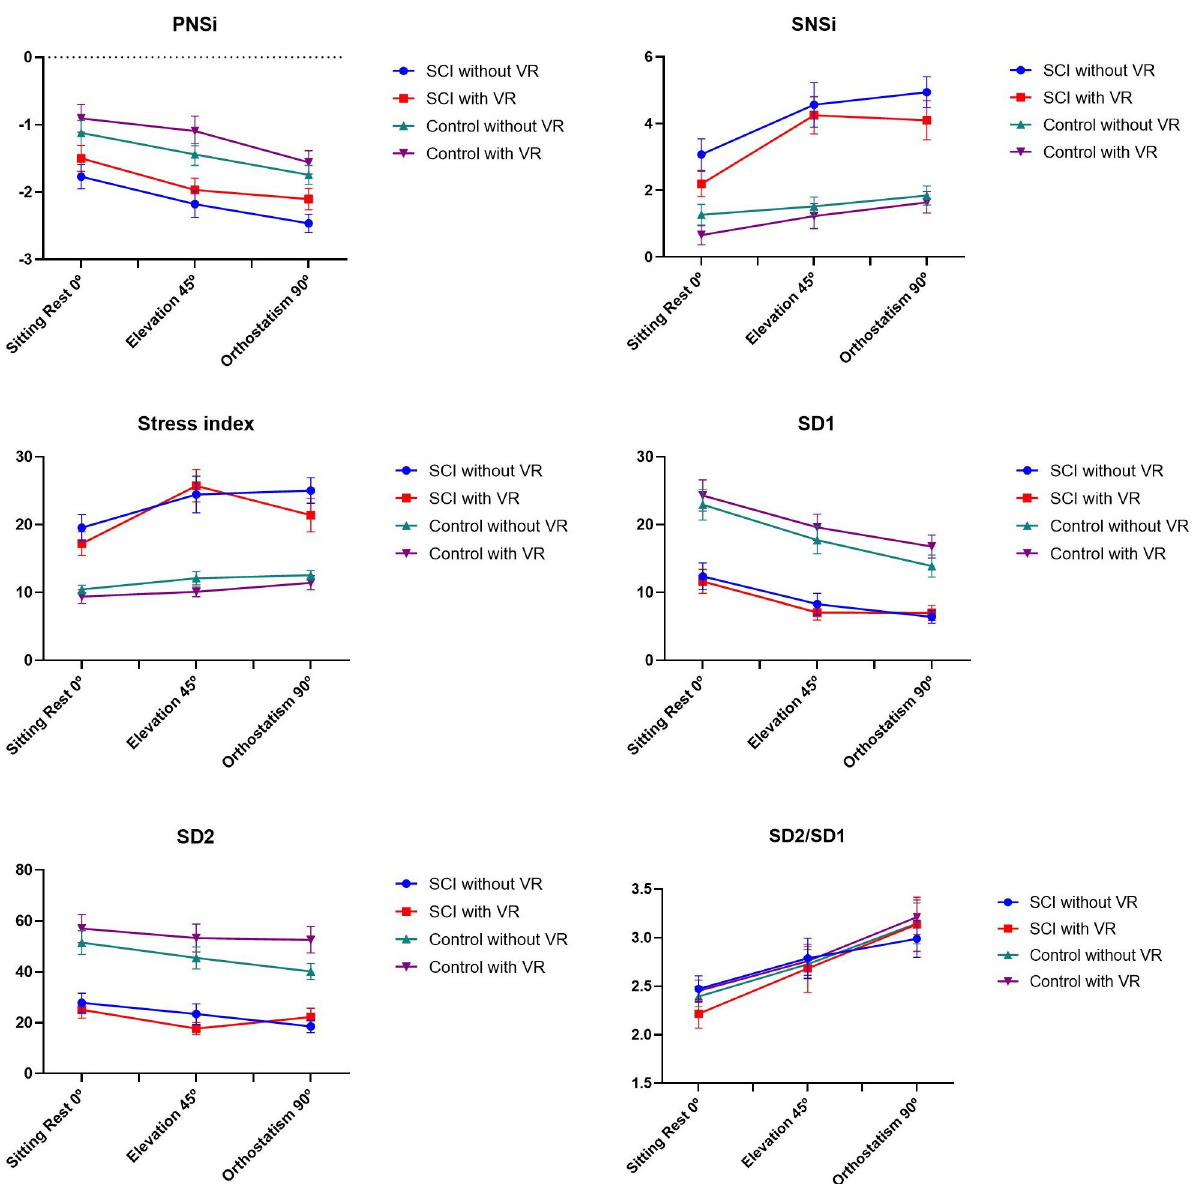
Fig 5. Representation of the mean and standard error of the sympathetic (SNSi), parasympathetic (PNSi), and stress (Stress index) indices for SCI and able-bodied controls, at the three moments (Sitting rest 0˚, elevation 45˚, and orthostatism 90˚), with and without virtual reality. SCI: spinal cord injury; VR: Virtual Reality activity; PNSi: index of parasympathetic nervous system; SNSi: index of sympathetic nervous system; Stress index: geometric measure of HRV that reflects the stress of the cardiovascular system; SD1: the standard deviation of instantaneous beat-to-beat RR interval variability in ms; SD2: standard deviation of continuous long-term RR interval variability in ms; SD2/SD1: ratio of short and long RR interval